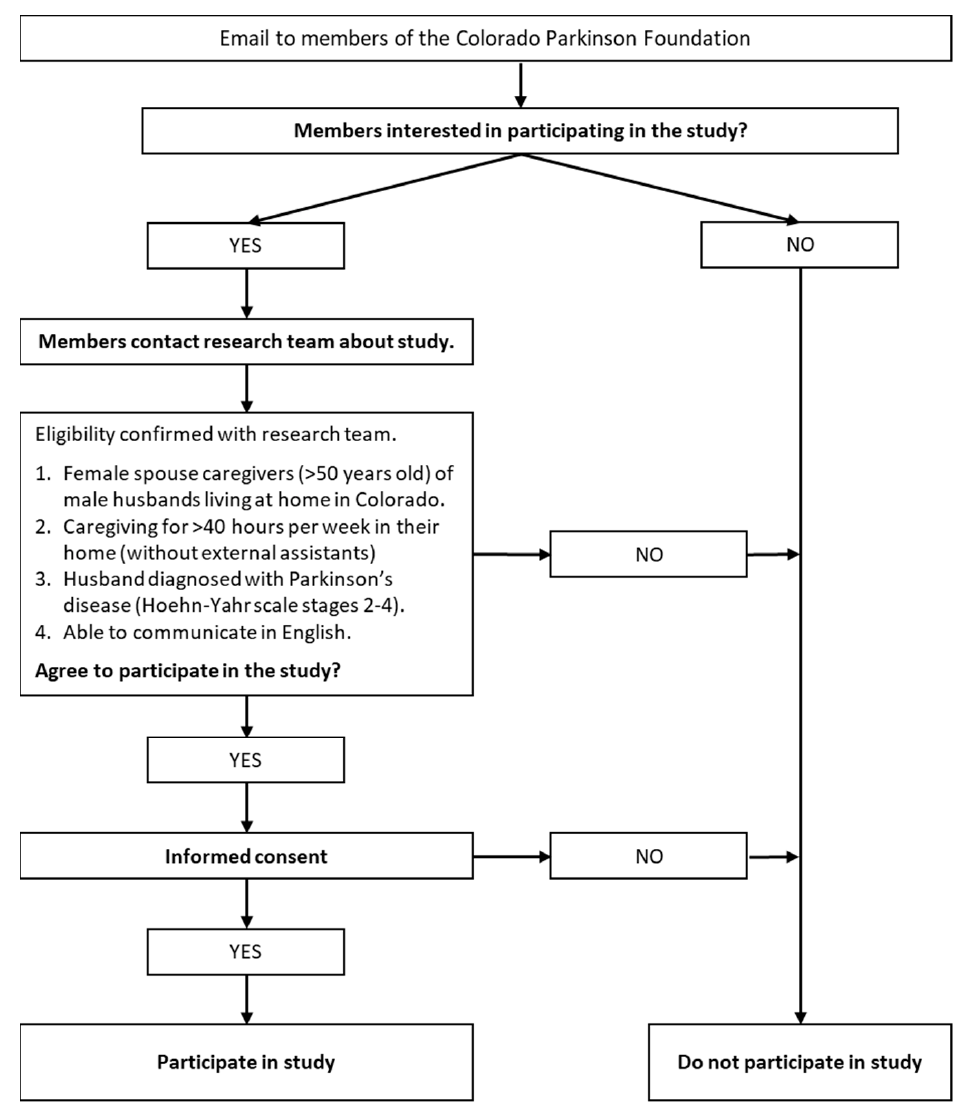
Figure 2. Recruitment Flowchart.